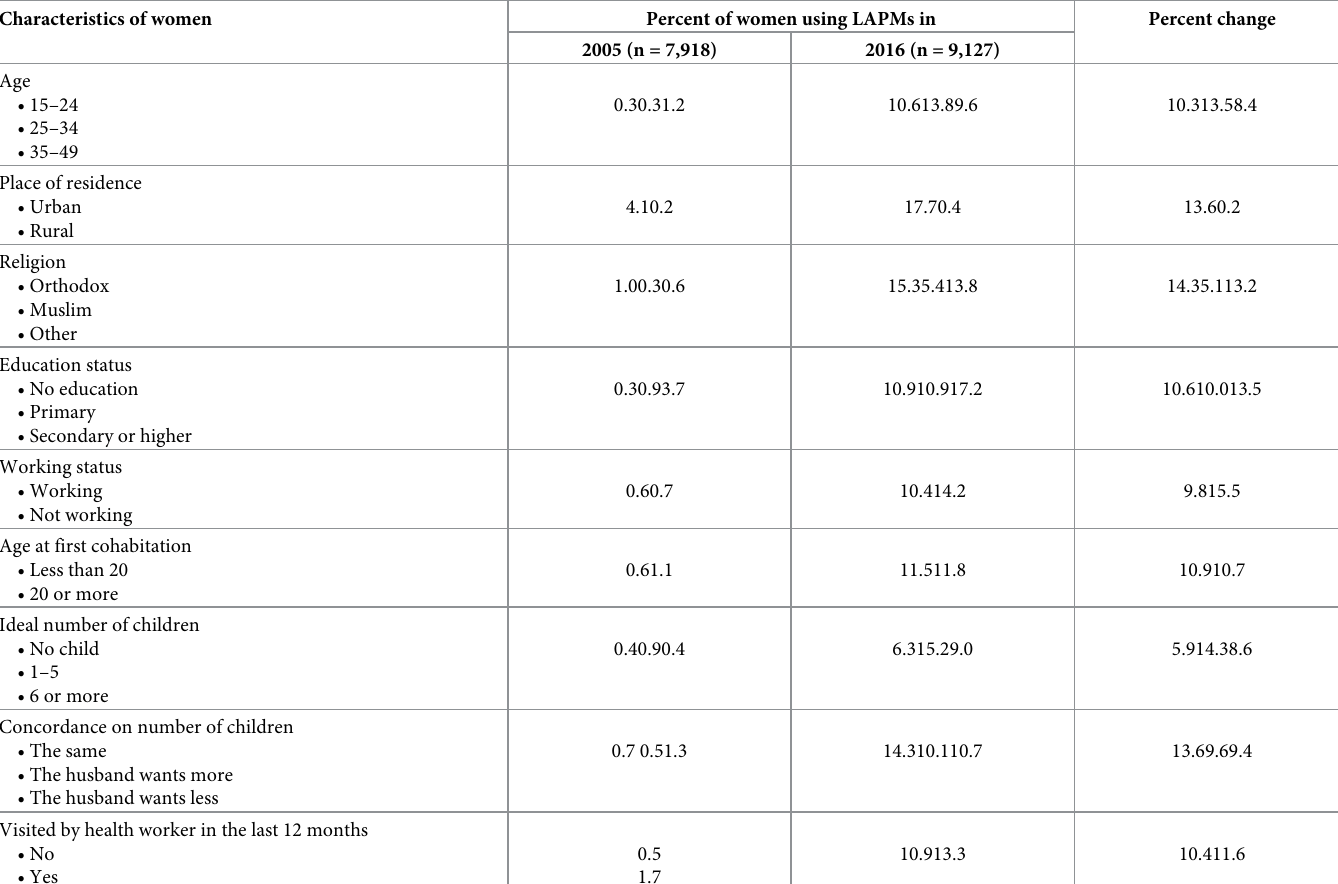
Table 2. Long-acting and permanent contraceptive methods use among married or in union reproductive-age women in Ethiopia and percent change by selected characteristics, 2005 and 2016 Ethiopian Demographic and Health Survey. Characteristics of